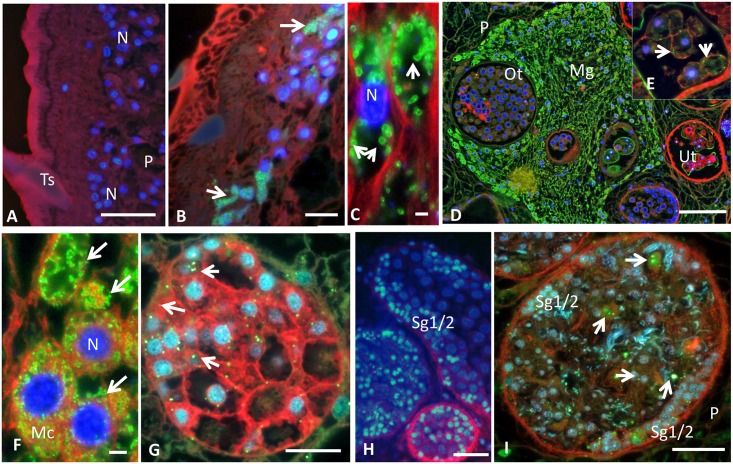
Immunofluorescence detection of Neorickettsia in adult Fasciola hepatica using polyclonal anti-serum raised against a recombinant surface protein of Neorickettsia of P. elegans (PeNsp-3, green labeling).DAPI (blue) and wheat hemagglutinin (red) were used to detect double stranded DNA and plasma membranes, respectively. (A) No green labeling was seen in the tegument of F. hepatica from Uruguay that were known to be devoid of Neorickettsia. (B) Clusters of Neorickettsia (arrows) in the tegument close to tegumental nuclei in F. hepatica from Oregon. (C) Numerous ‘donut’-shaped endobacteria (arrows) in the parenchyma in F. hepatica from Oregon. (D) Labeling of large numbers of Neorickettsia in the Mehlis’ gland and labeling of single endobacterium in the ootype or intrauterine eggs of F. hepatica from Oregon. (E) Magnification of a region proximal to (D) showing granular staining of single endobacterium in intrauterine eggs. (F) Clusters of Neorickettsia rods (arrows) in the cytoplasm of Mehlis’ cells of F. hepatica Oregon. (G) Individual Neorickettsia endobacteria (arrows) in a vitelline follicle with different stages of vitelline cells of F. hepatica Oregon. (H) No green staining indicative of Neorickettsia were found in the testis of F. hepatica from Uruguay tested negative for Neorickettsia by PCR. (I) Neorickettsia endobacteria (arrows) in the testis of F. hepatica Oregon with spermatogonia in the periphery and developing spermatozoa in the center. N, nucleus; Ts, tegument spine; P, parenchyma; Mg, Mehlis’ gland; Ot, ootype; Ut, uterus; Mc, Mehlis’ cell; Sg1/2, primary and secondary spermatogonia; Bar corresponds in A-B, D-I to 100 μm and in C to 1 μm.